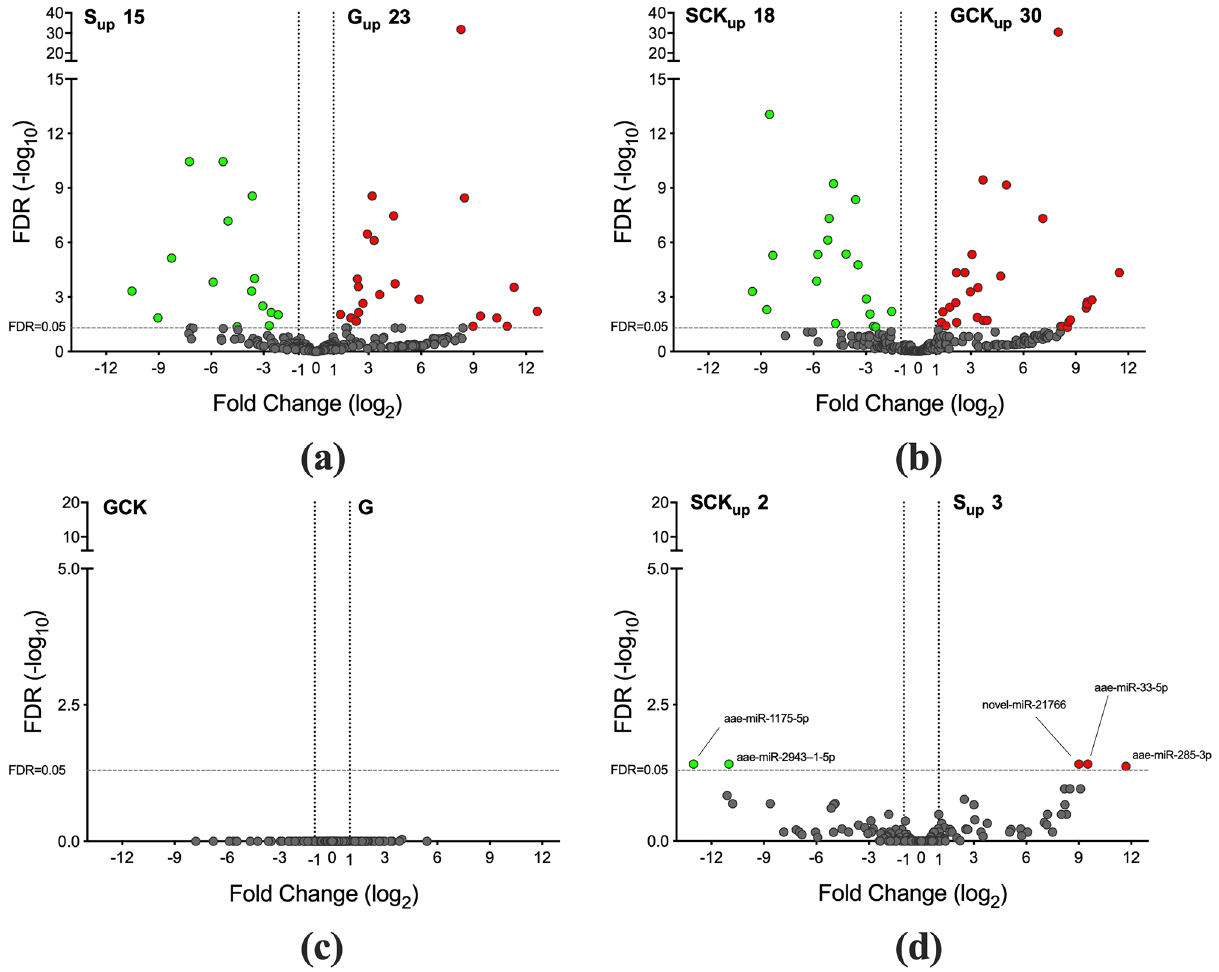
Figure 4. Differential abundance of miRNAs in uninfected and CHIKV-infected Aedes aegypti saliva and salivary glands. The volcano plots show the differential abundance of miRNAs in the following pairwise comparisons: ( a ) S-G; ( b ) SCK-GCK; ( c ) GCK-G; ( d ) SCK-S. The log2 of fold change (FC) versus the negative log10 of false discovery rate (FDR) as calculated by edgeR are reported. Vertical dotted lines mark |log2(FC)|= 1, the horizontal dashed line marks FDR = 0.05. miRNAs with a |log2(FC)| > 1 and FDR < 0.05 in the different pairwise comparisons are shown either in green or